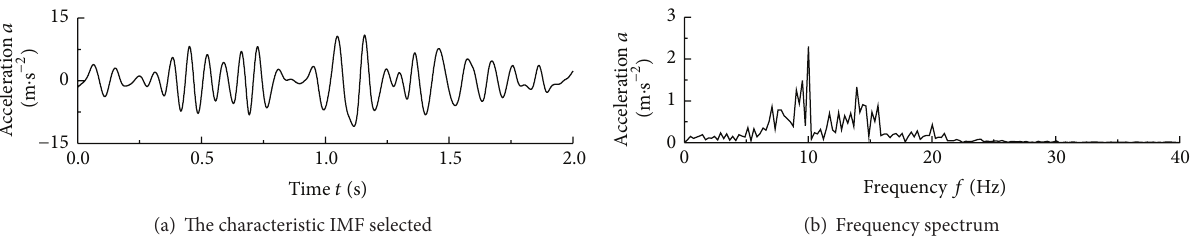
Figure 12: Analysis results of the signal presented in Figure 10 by EEMD: (a) the characteristic IMF and (b) FFT spectrum.